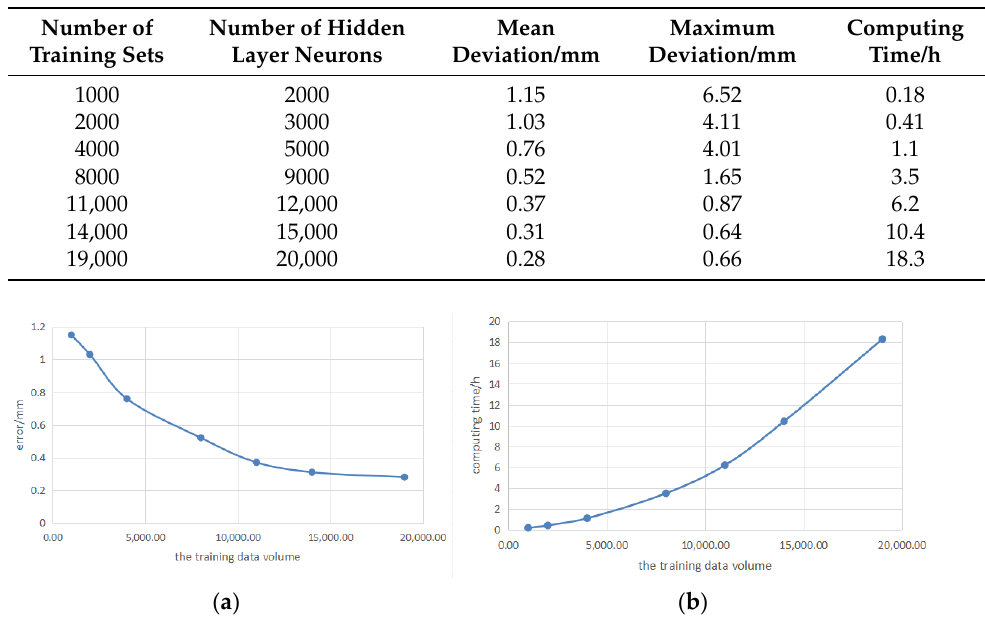
Figure 13. ( a ) The relationship between the training data volume and the average error and ( b ) the relationship between the training data volume and computing time. Table 2. Average deviation and maximum deviation at different working